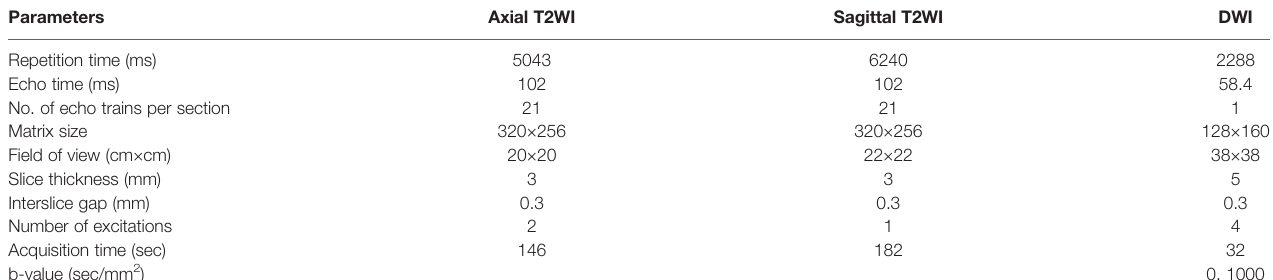
TABLE 1 | MRI sequence parameters.